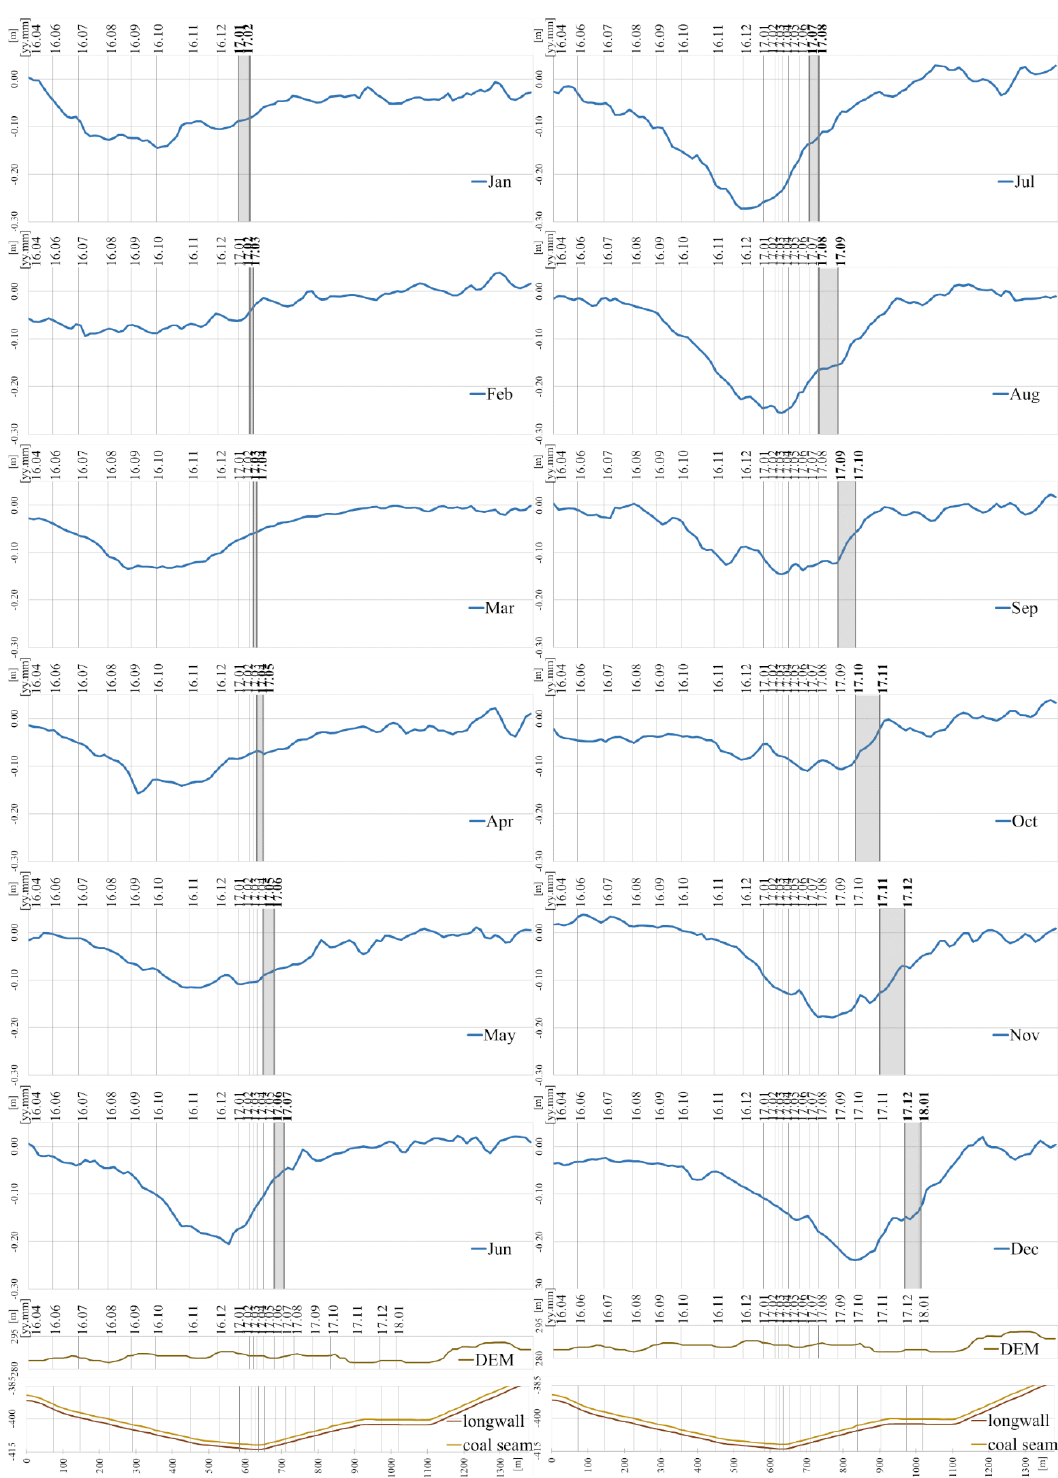
Figure 16. Profile B’B” (longwall No. 5) through the DInSAR. The blue curves show the vertical subsidence by month in 2017. On the bottom of the figure, profiles of the DEM surface and depth and thickness of coal seam are presented.